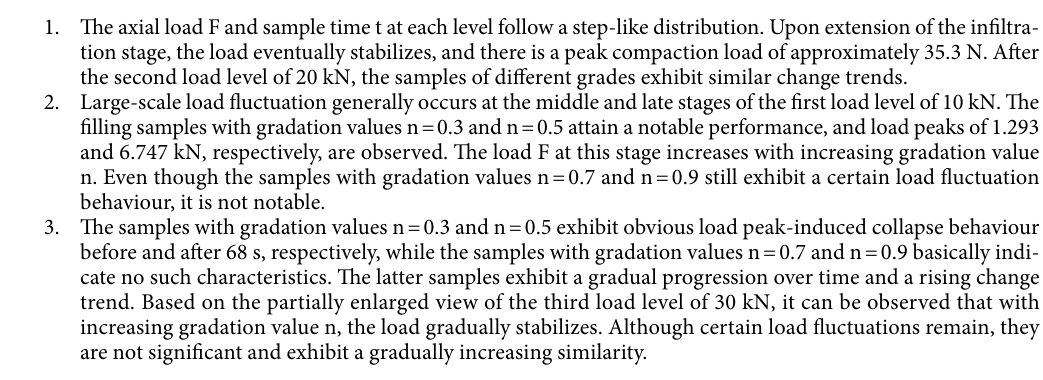
Figure 4. Water flow conversion process in the water inrush channel area at the top of the